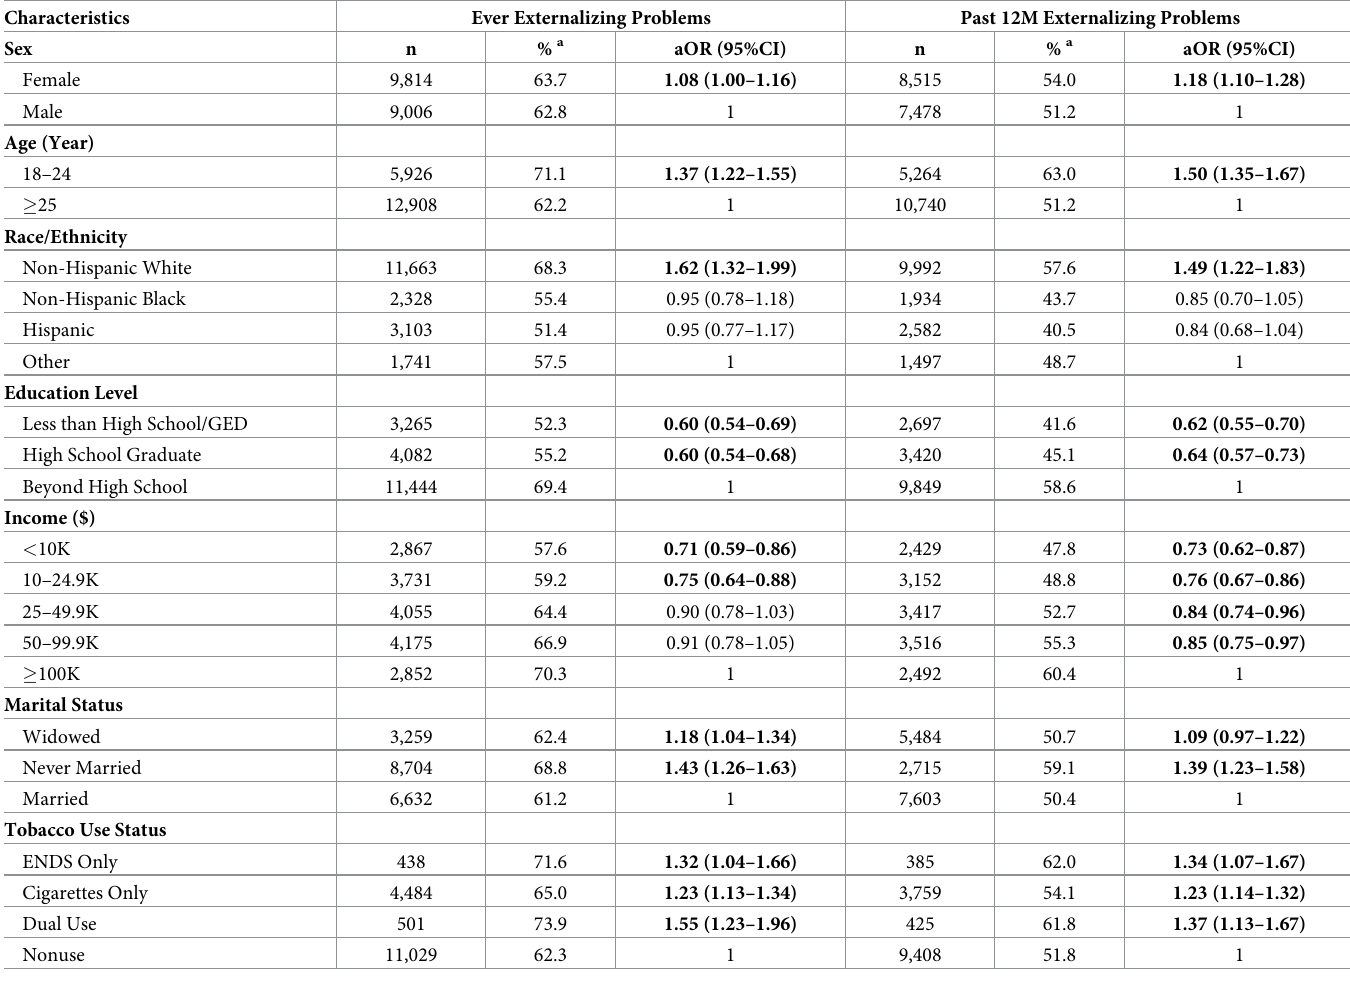
Table 4. Association between ever � and past 12 months �� externalizing problems and sociodemographic